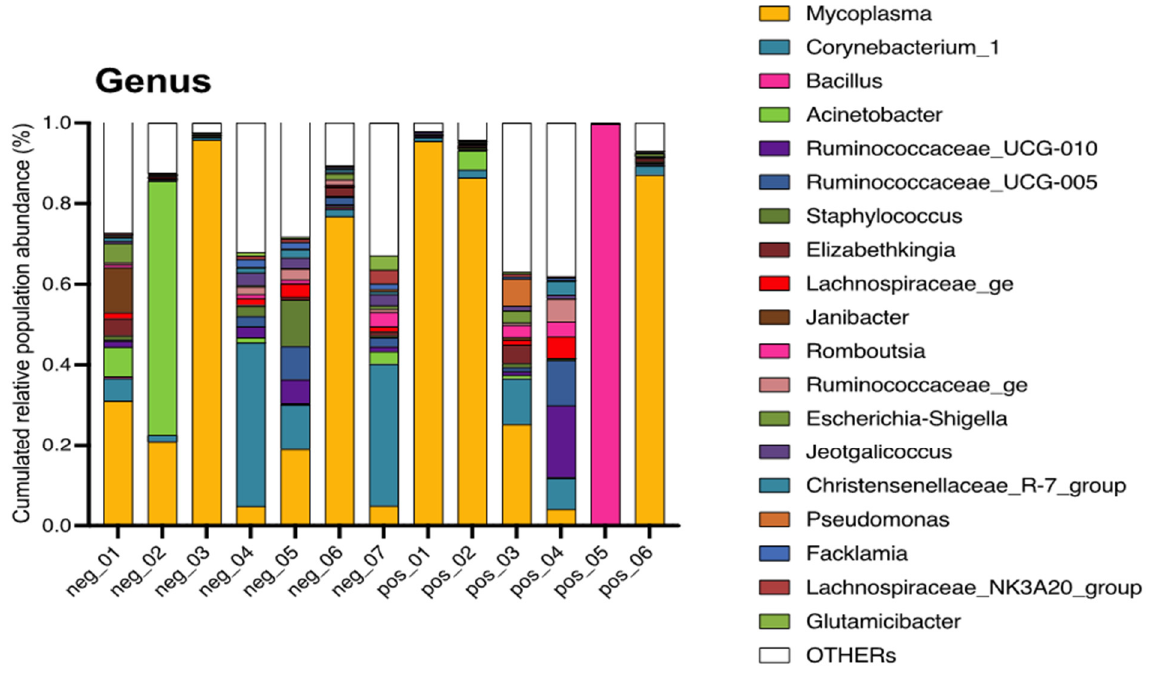
Figure 2. Genera with a mean relative abundance above 0.5% regarding the 13 cross-sections taken in surgical site during the elective caesarean section realisation in Belgian blue cows.